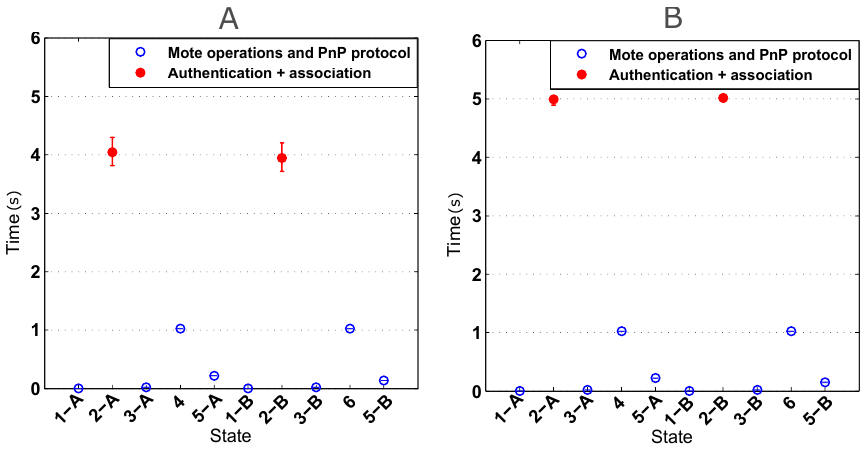
Figure 12. Self-configuration and self-registration times using Linksys WRT54G AP ( A ) and SMCWEB-N AP ( B